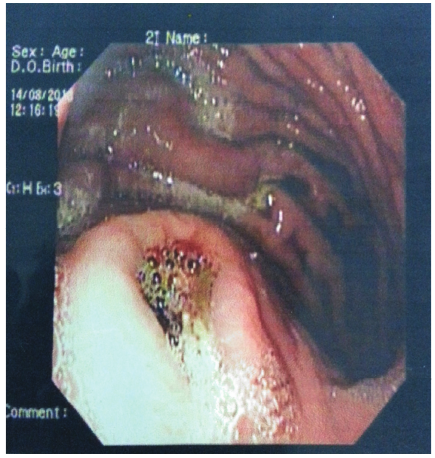
Figure 1: UGI endoscopy showing a picture of leiomyoma.